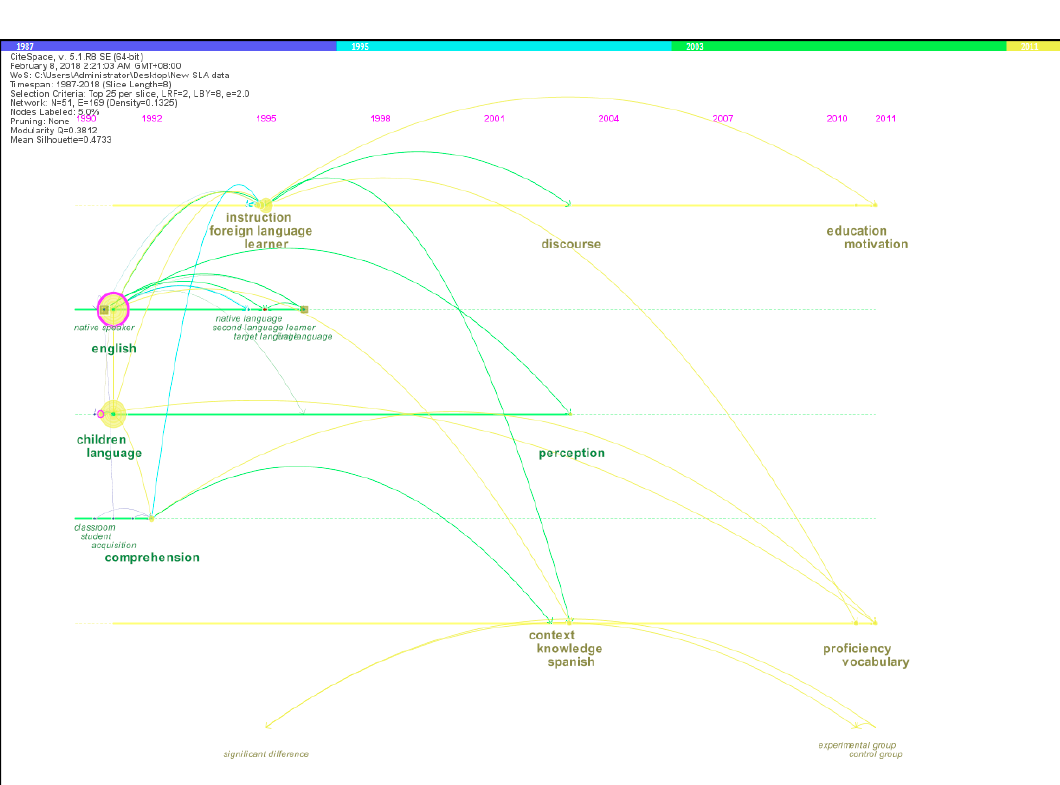
Figure 5. The timeline view of the keyword co-occurrence network (1987–2018).